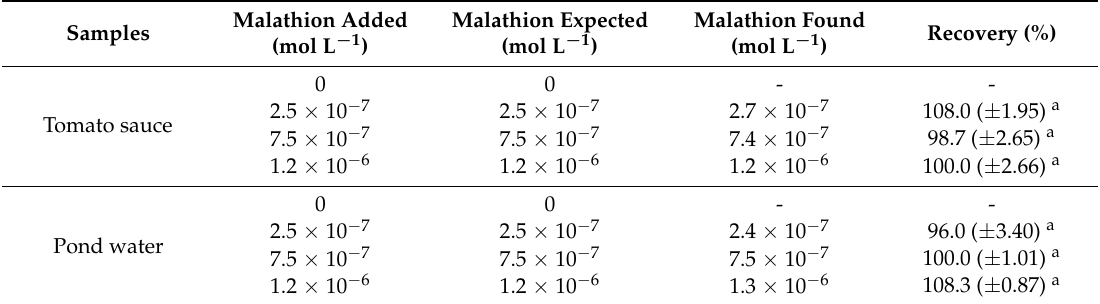
Table 2. Recoveries of malathion from tomato sauce and pond water